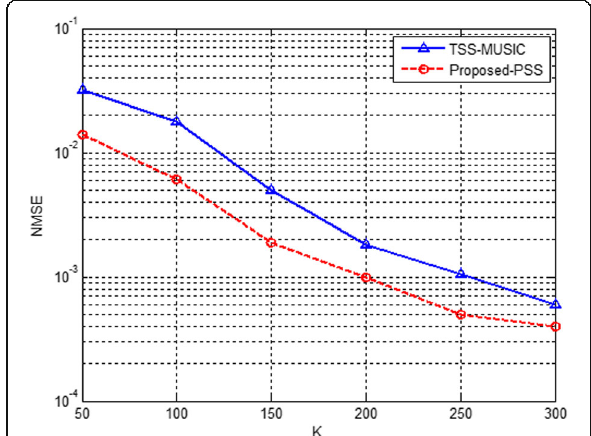
Fig. 12 The NMSE versus number of block ’ s pilots. The figure plots the reverses number of block ’ s pilots via 10000 Monte Carlo simulations with SNR = 10 dB.